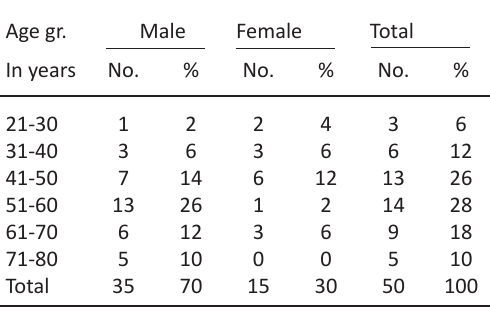
Table 1. Age and Sex Distribution of Cases studied) Age